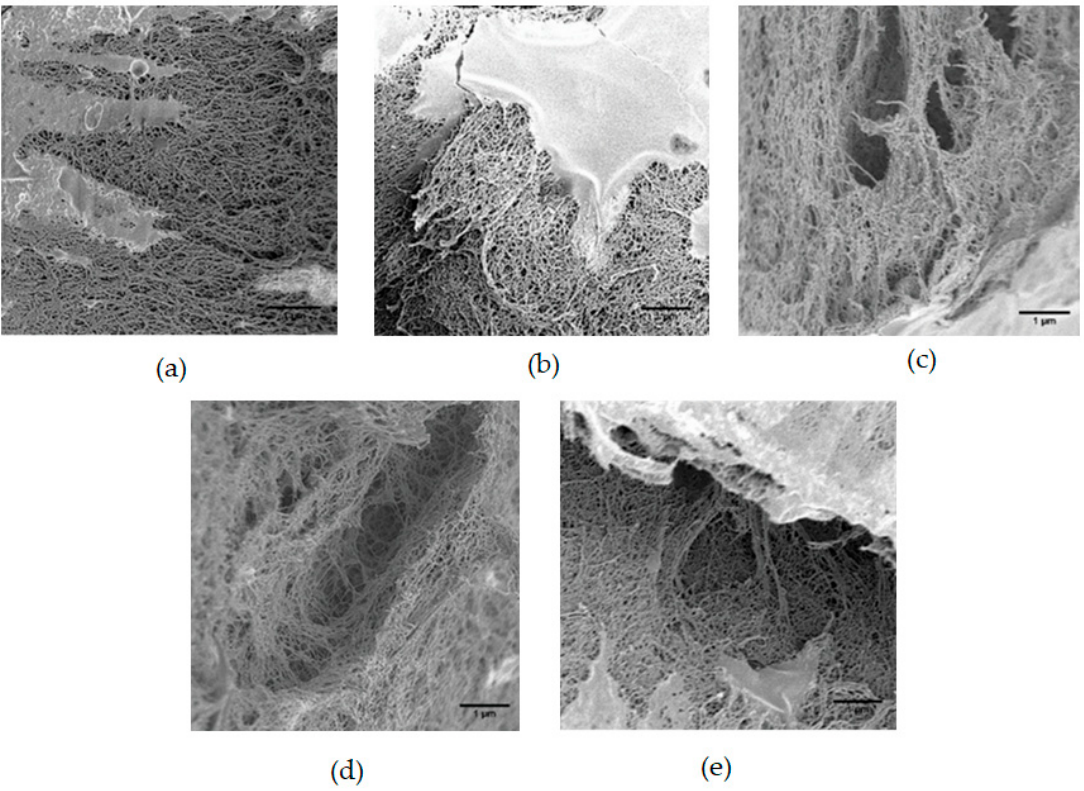
Figure 3. Scanning electron microscopy images of three-dimensional printed fibrin sca ff olds crosslinked with di ff erent concentrations of genipin: ( a ) 0 µ M, ( b ) 1 µ M, ( c ) 2.5 µ M, ( d ) 5 µ M, and ( e ) 10 µ M. Reprinted under a Creative Commons Attribution 4.0 International License from Reference [61] from the journal Scientific Reports.